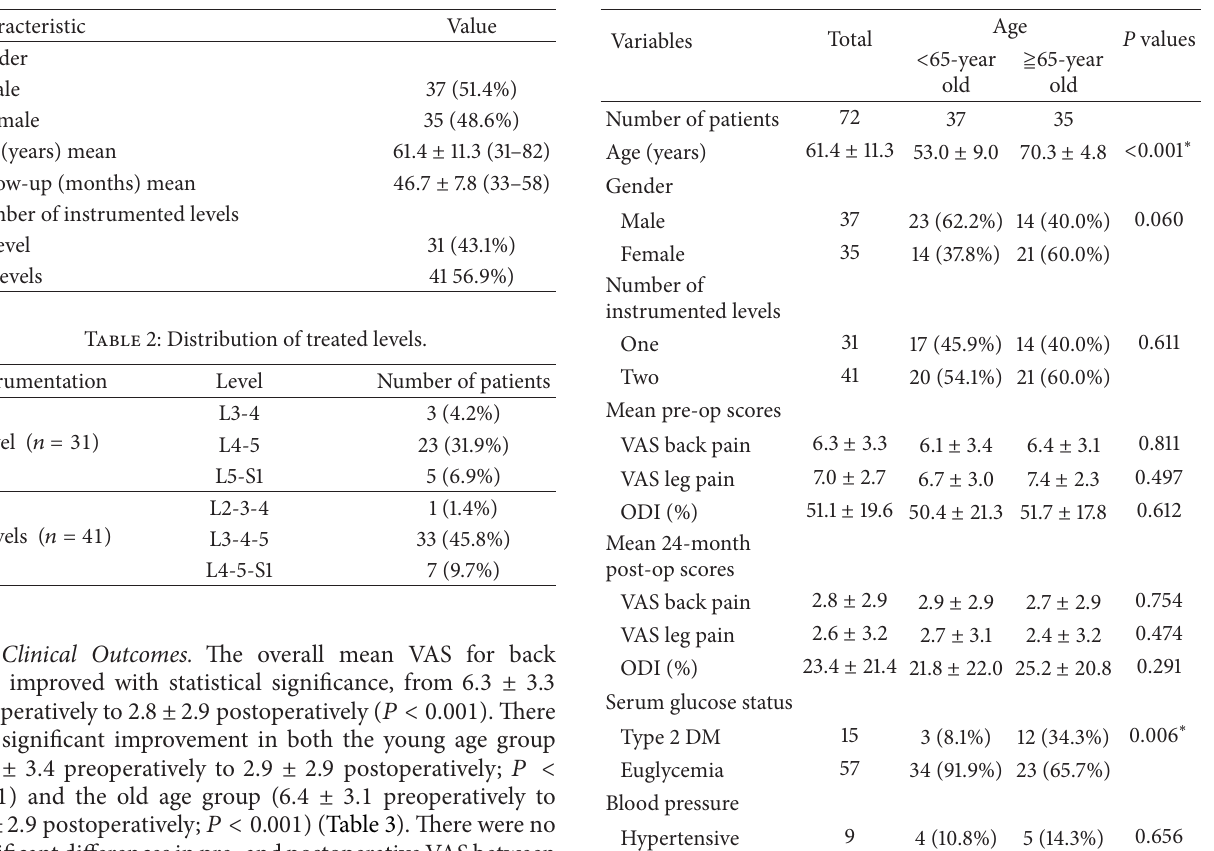
Table 1: Clinical and demographic characteristics ( 𝑛 = 72 ).